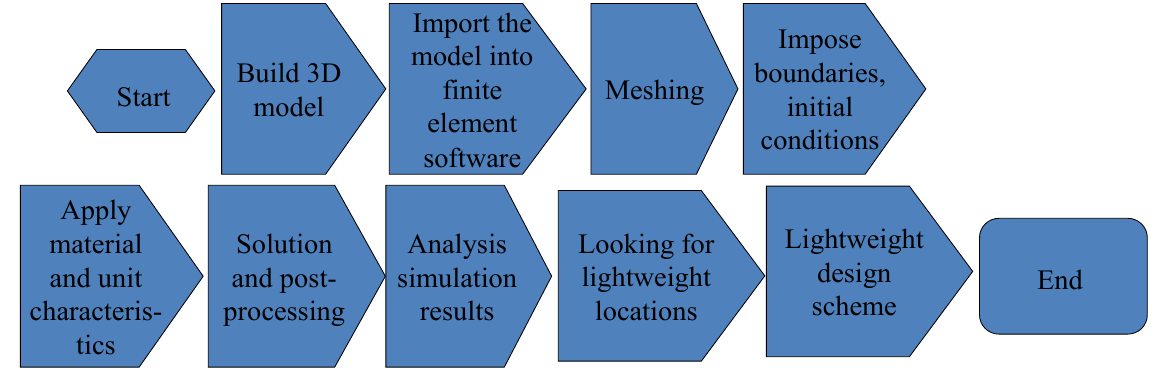
Figure 2. Finite element analysis process and lightweight scheme.